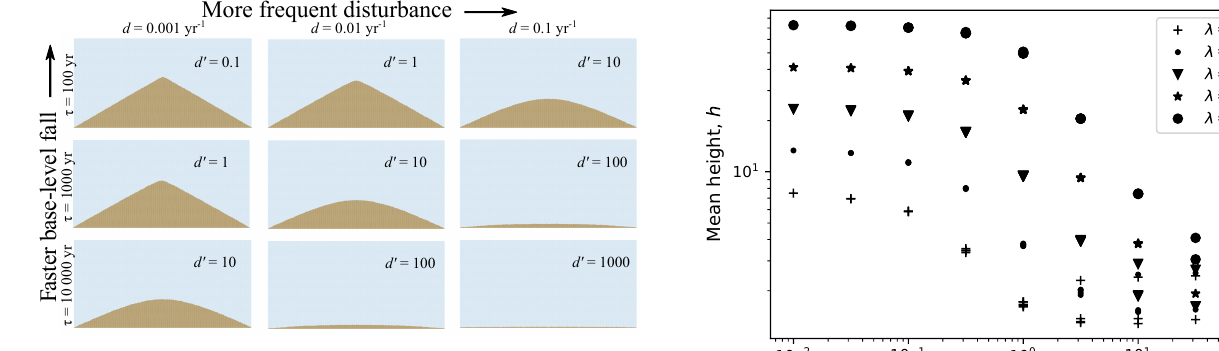
Figure 8. Equilibrium topographic cross sections using only re- golith particles (no rock) and a variety of disturbance frequen- cies ( d ) and time interval between base-level fall events ( τ ). Fast basal incision and/or infrequent disturbance lead to planar thresh- old hillslopes; slow basal incision and/or frequent disturbance lead to parabolic hillslopes.